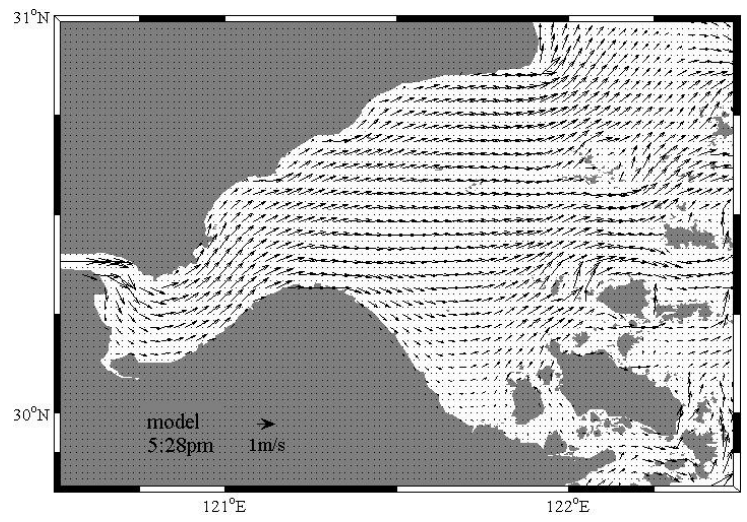
Figure 9. The surface flow field from the numerical simulation corresponding to times that the GOCI derived SSC images on 1 January 2014 were obtained.